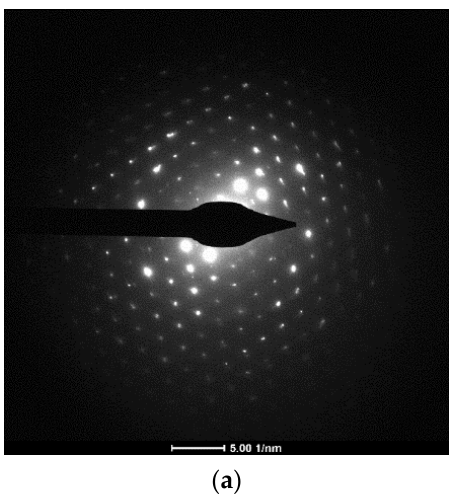
Figure 4. Bright field TEM of ( a ) cement and ( b ) concrete dust on SLG grid.